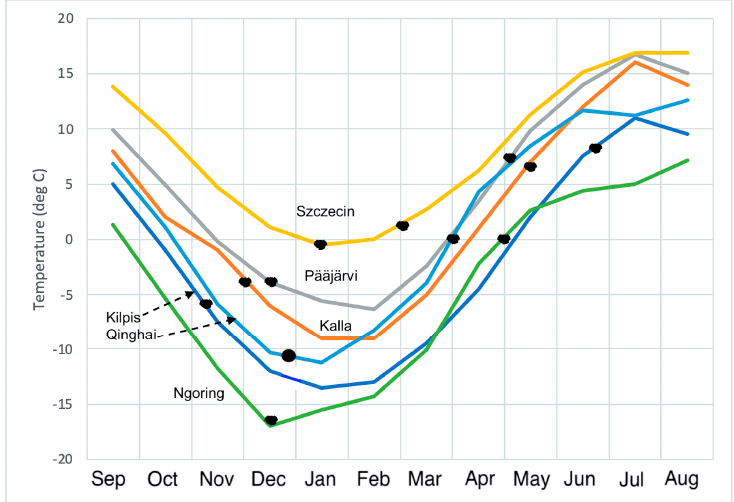
Figure 3. Annual average temperature cycle in the lakes under study. The black dots show the freezing and breakup dates.